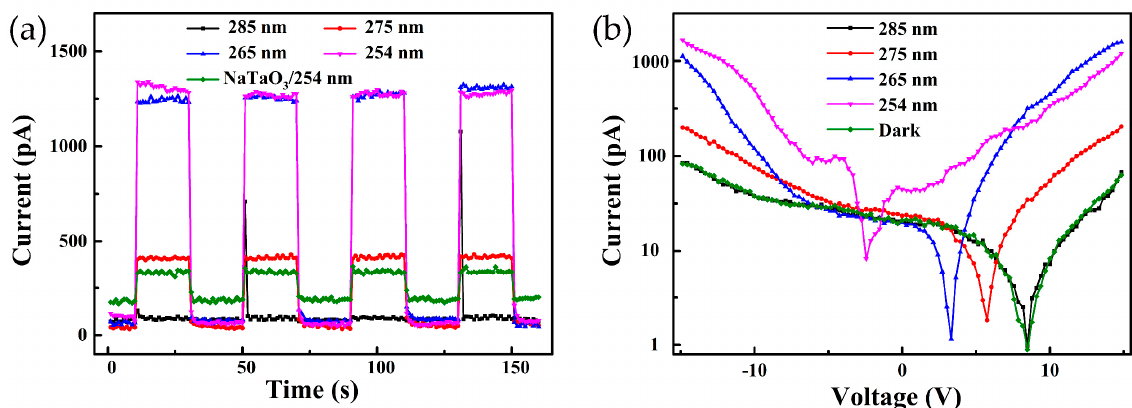
Figure 5. ( a ) The time-dependent photocurrent response of the NaTaO 3 /TiO 2 and pure NaTaO 3 film-based devices under UV illumination after different testing cycles at − 15 V bias; ( b ) the I–V characteristics of the NaTaO 3 /TiO 2 detector in dark and under illuminations of different wavelength.